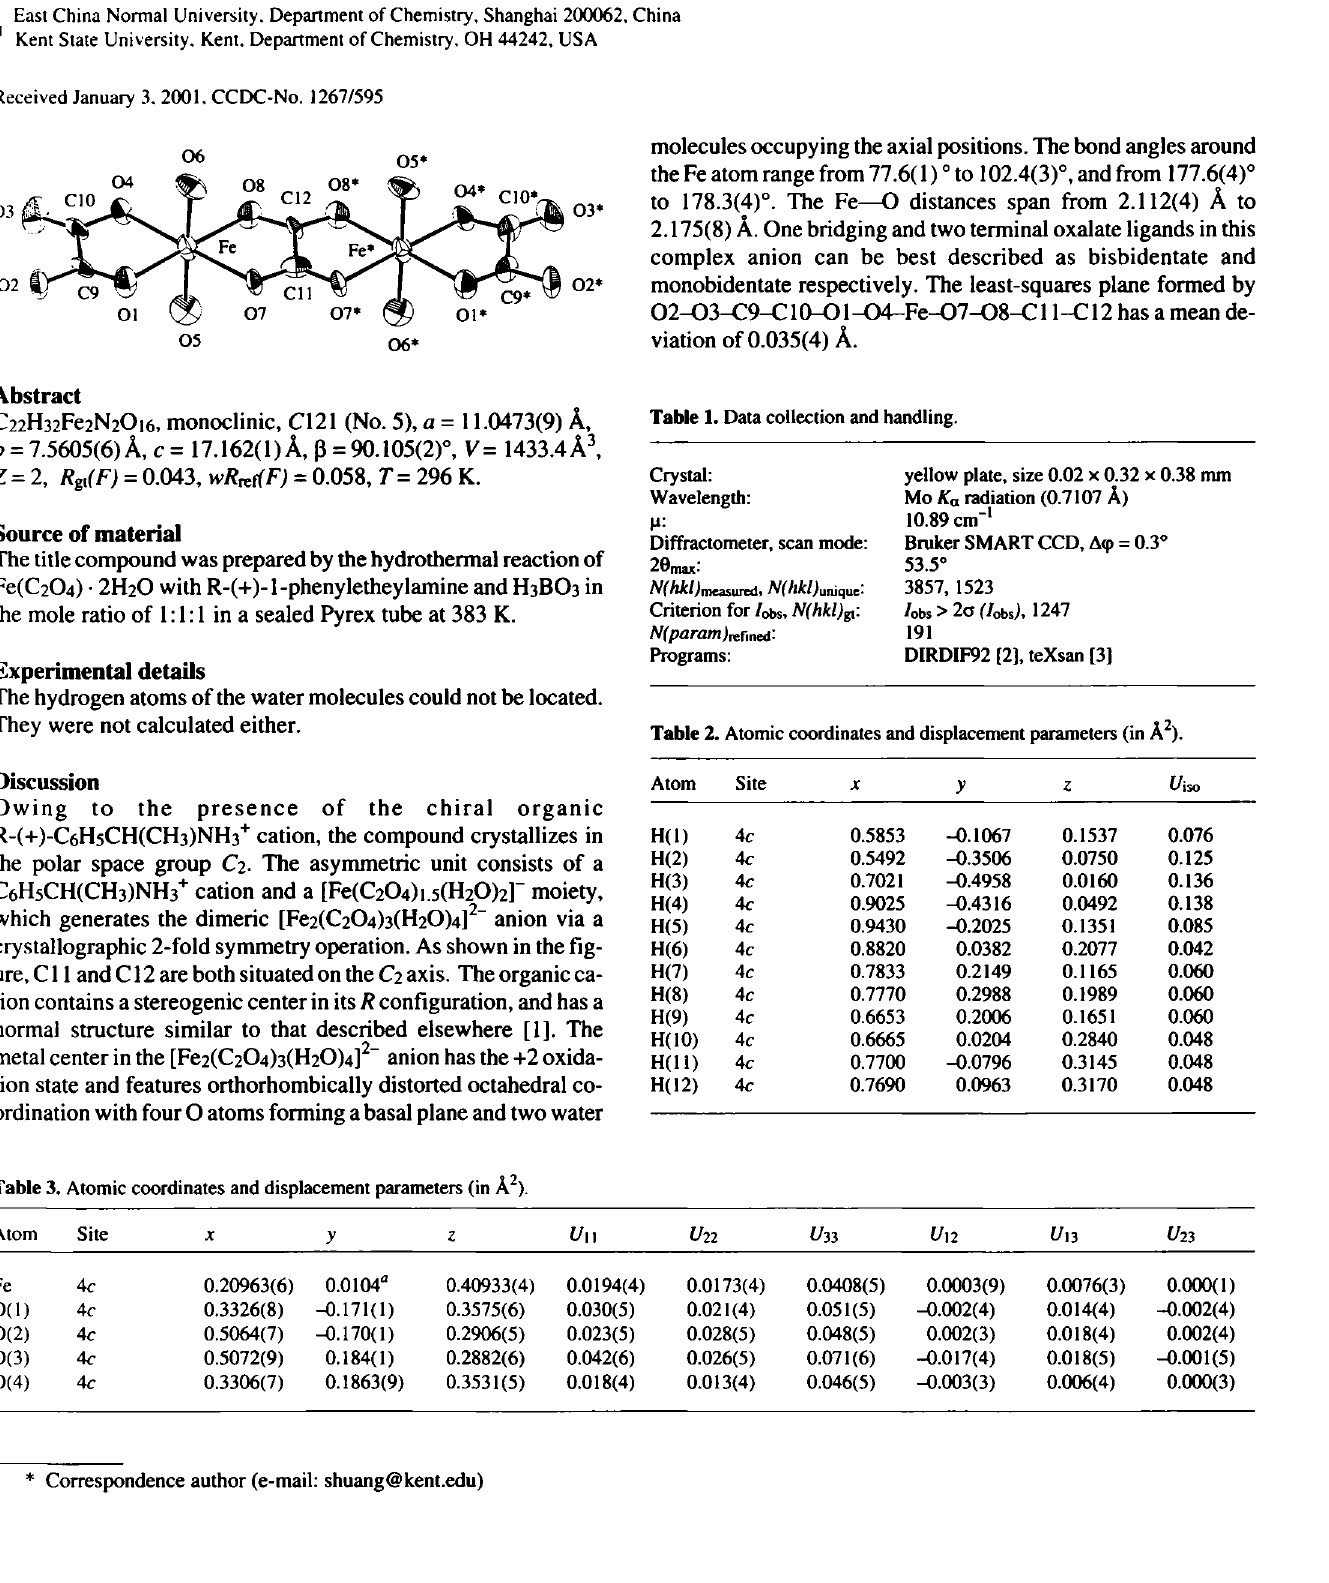
Table 3. Atomic coordinates and displacement parameters (in Ä 2 ). Atom